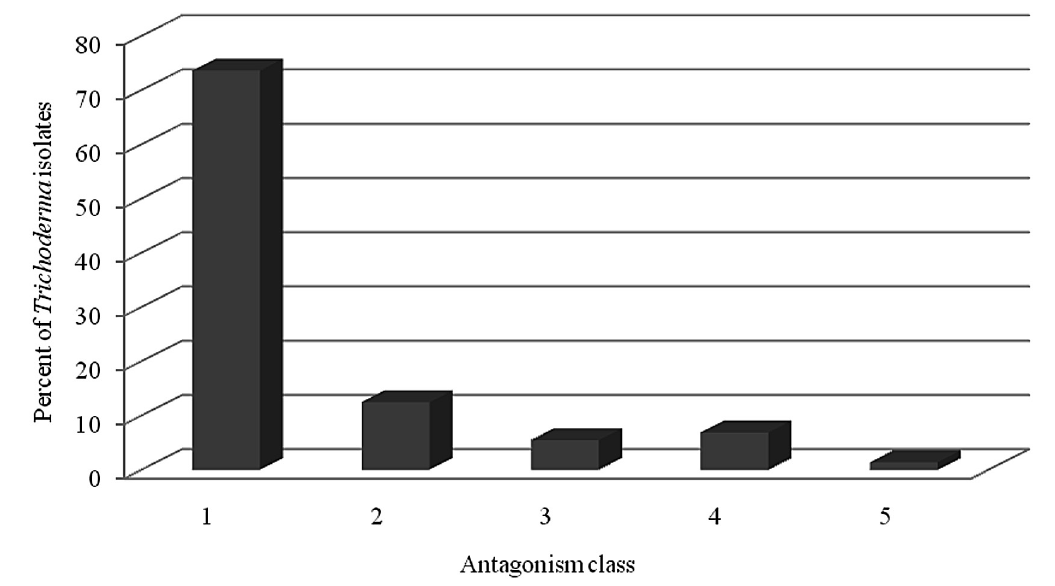
Figure 3. Antagonistic reactions of Trichoderma spp. with Rhizoctonia solani in dual culture tests. 1, Trichoderma completely overgrows the pathogen and covers the entire medium surface; 2, Trichoderma overgrows at least two thirds of the medium surface; 3, Trichoderma and Rhizoctonia each colonize 50% of the medium surface and neither organism appears to dominate the other; 4, Rhizoctonia colonizes at least two-thirds of the medium surface and ap- pears to withstand encroachment by Trichoderma; 5 = Rhizoctonia completely overgrows the medium